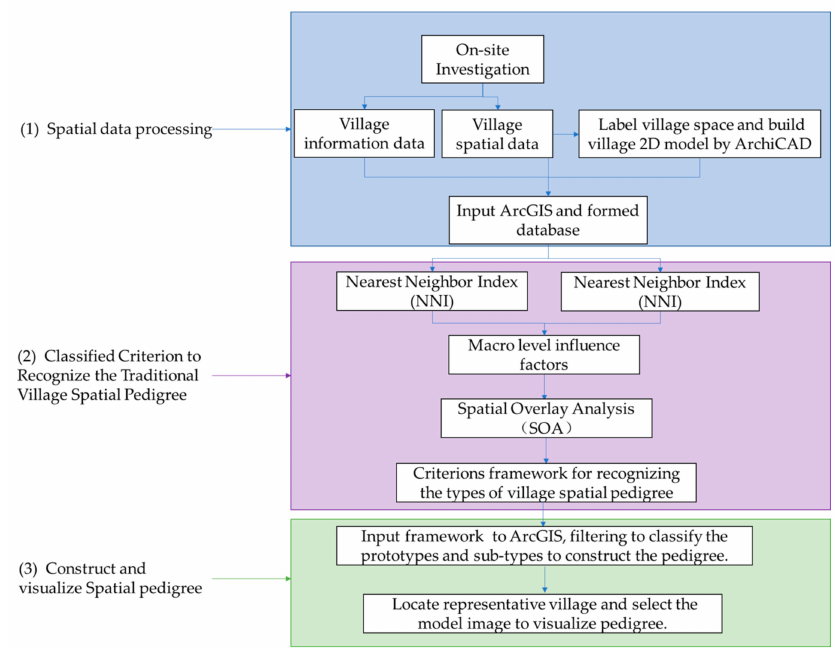
Figure 3. Research steps: edited by